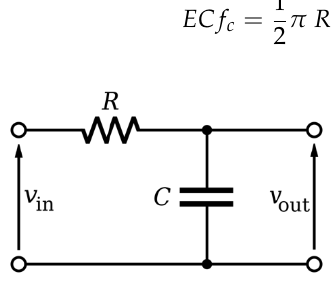
Figure 3. RC filter circuit.